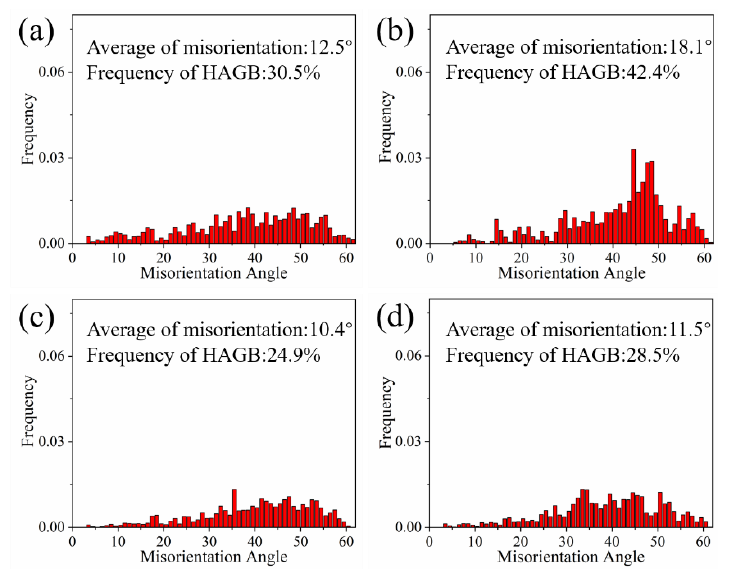
Figure 10. Distribution of misorientation angles of the alloys after T6 treatment ( a ) AL1; ( b ) AL2; ( c ) AL3; ( d ) AL4.